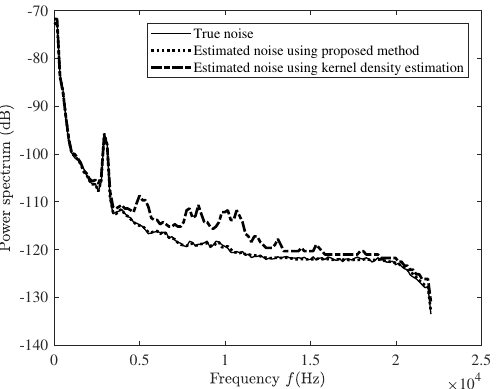
Figure 12. Comparison of the proposed method to kernel estimation for noise